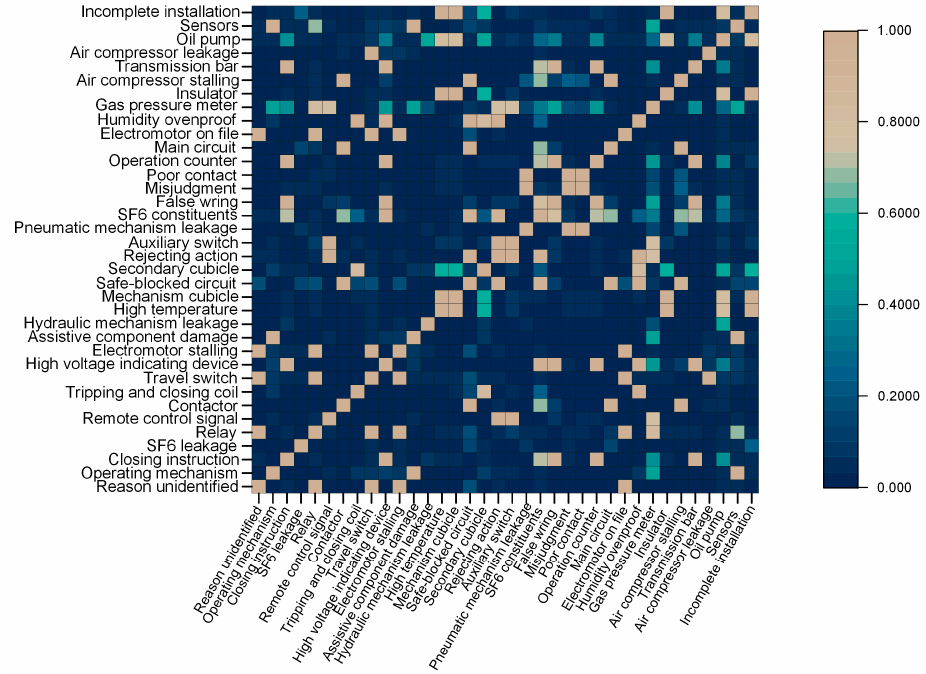
Figure 14. Similarity map for all the failures in the real-word dataset.